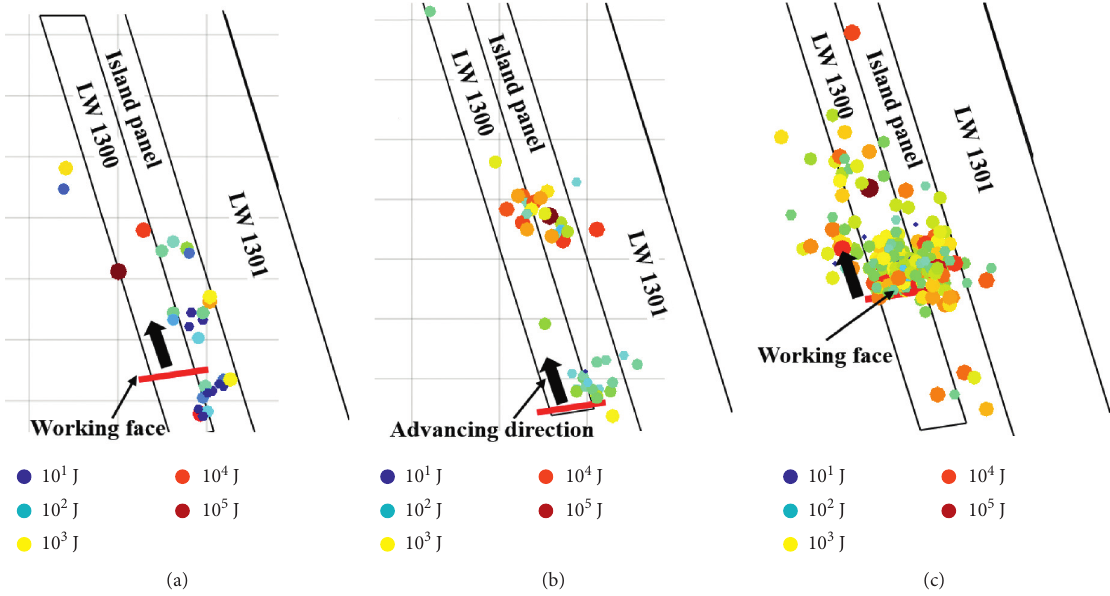
Figure 10: Distribution of microseismic events around the working face at different advancing speeds: (a) 1.6 m/d; (b) 4.0m/d; (c)